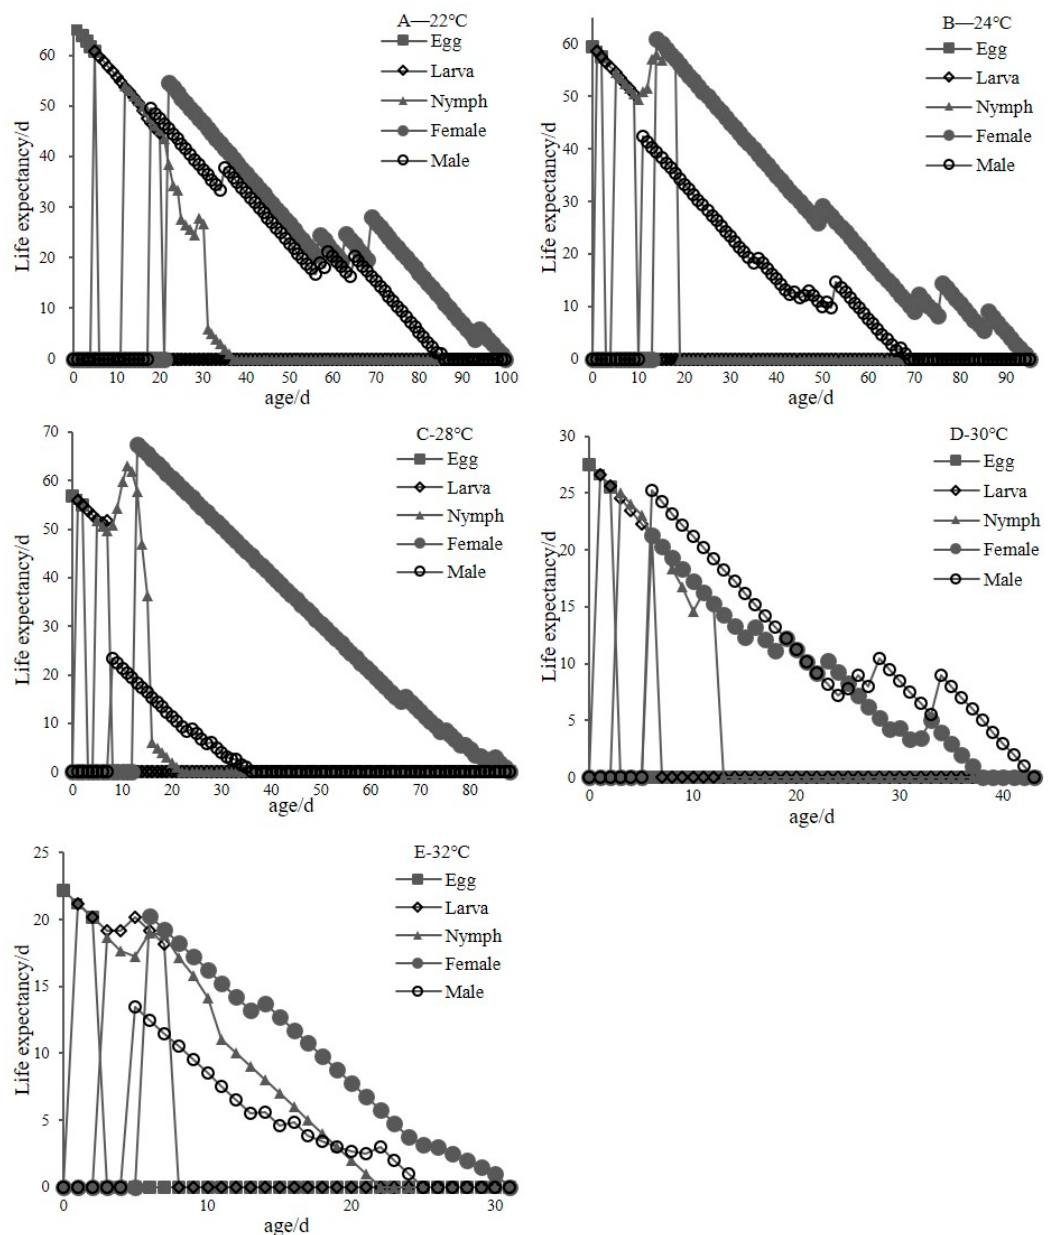
Figure 5. Age-stage specific life expectancy ( e xj ) of C. malaccensis at di ff erent temperatures (A-E are 22, 24, 28, 30 and 32°C, respectively)